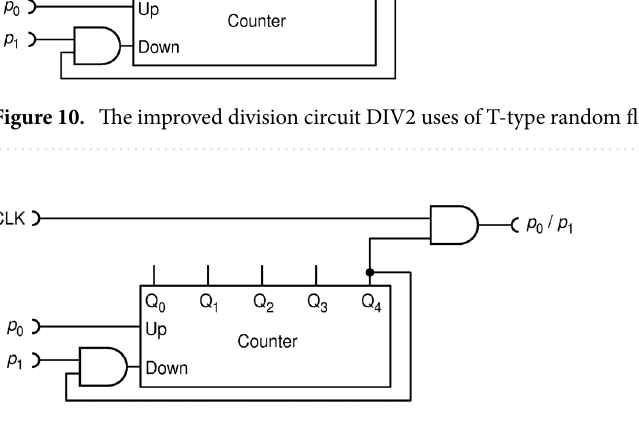
Figure 11. A simple and precise deterministic division circuit